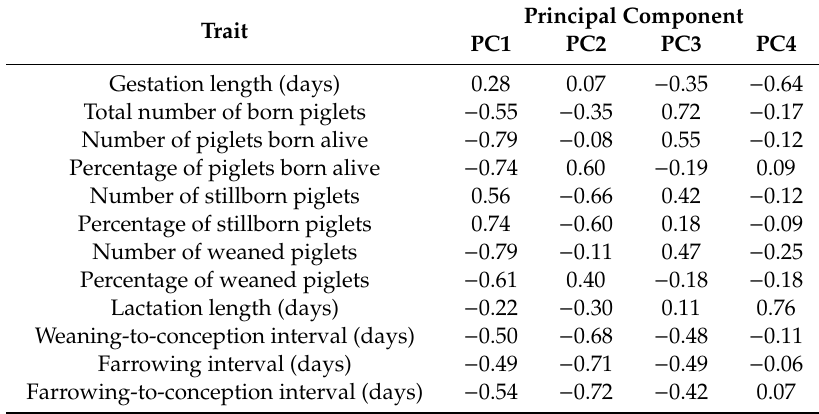
Table 5. Correlation coe ffi cients between the original traits and the first four principal components.